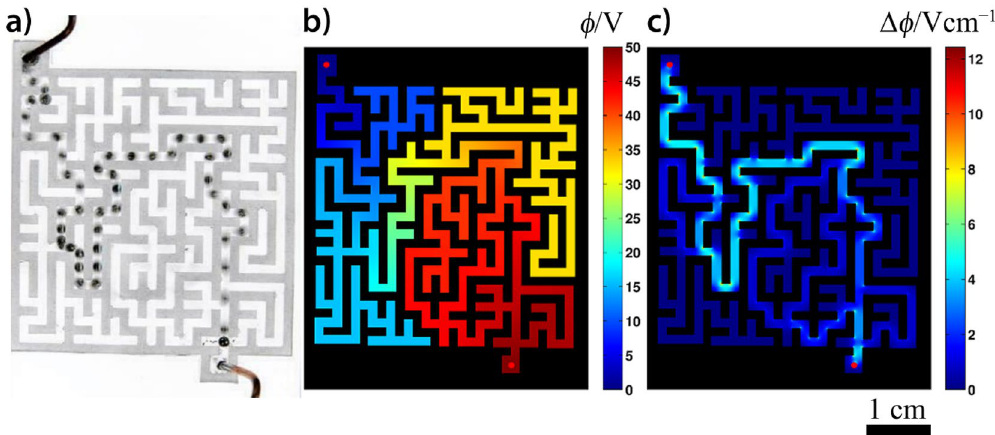
Figure 2. ( a ) Solution of a two-dimensional maze made of silicone using a Hg droplet ( m = 20 mg) in an electric field using the galvanostatic condition ( I = 5.0 mA). Two electrodes were placed at the entrance (anode) and exit (cathode) of the maze filled with the solution of sulfuric acid ( c = 10 mM). The depth of the solution in the maze was ~ 1 mm. The superimposed image shows the position of the droplet every 0.04 s. ( b ) The calculated electric field and ( c ) the magnitude of the gradient in the maze. The steepest descent of the electric field is along the shortest path within the maze, which was followed by the